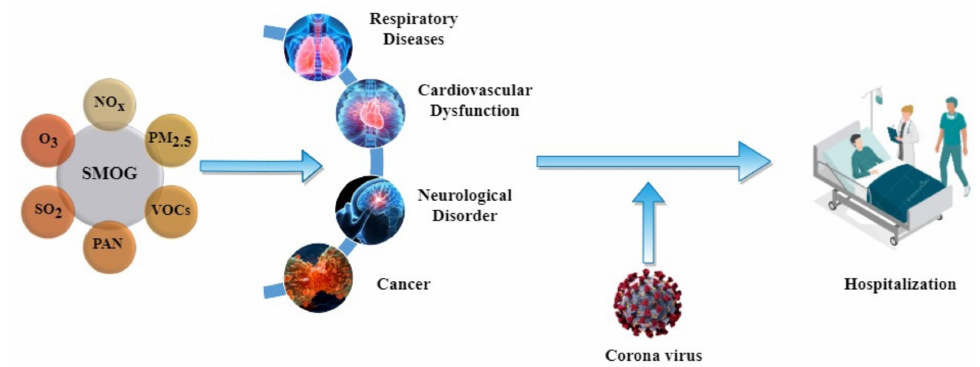
Figure 1. Relationship between COVID-19 and